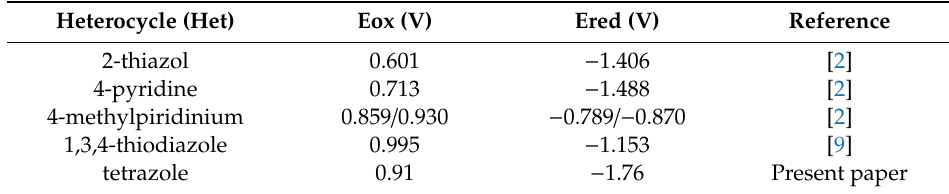
Table 2. Redox potentials of some 1 ‐ azulene ‐ azo ‐ heterocycles Ar ‐ N=N ‐ Het for different structures of heterocycle (Het).